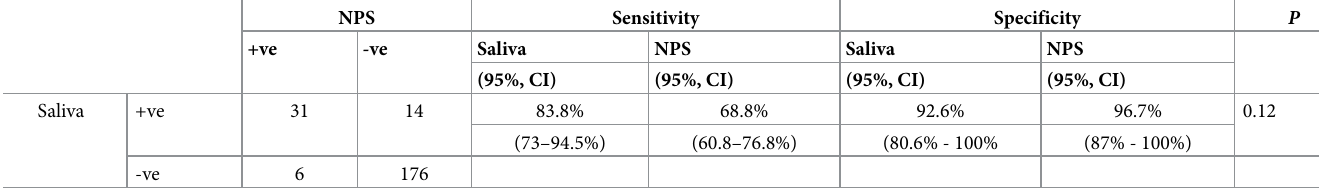
Table 6. Comparison of saliva sensitivity against NPS and agreement between saliva and NPS swab for comparative evaluation of saliva and NPS for SARS-CoV-2 detection using RT-qPCR among COVID-19 suspected patients at Jigjiga, Eastern Ethiopia (n = 227).